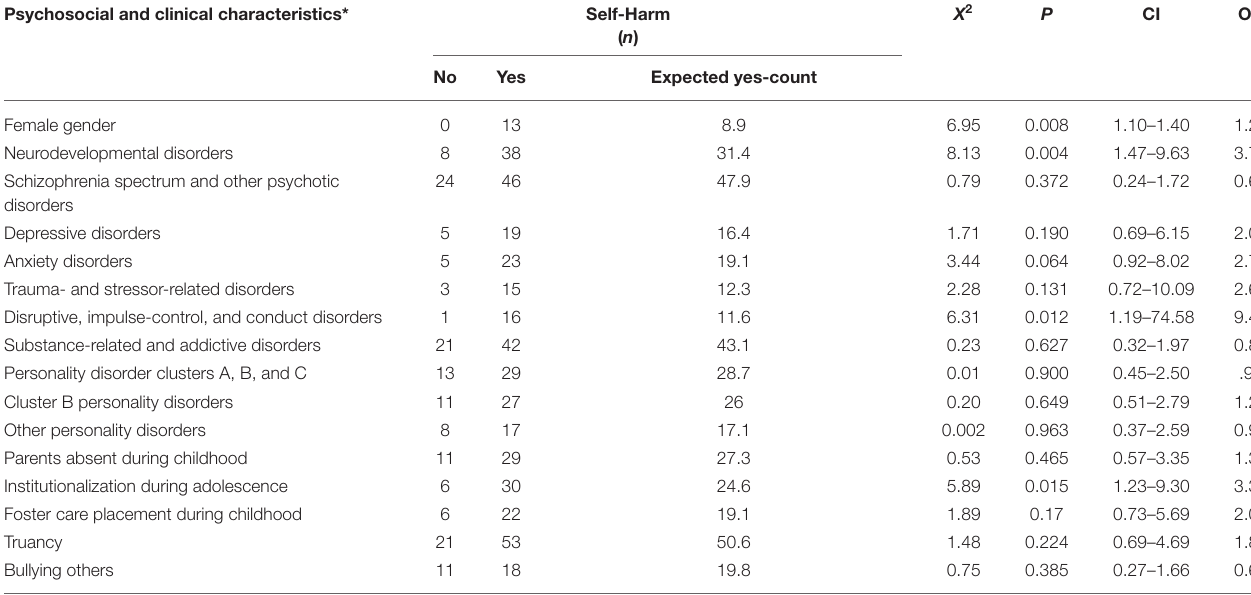
TABLE 5 | Psychosocial and clinical risk factors of self-harm (NSSI & suicide attempts). Psychosocial and clinical characteristics* Self-Harm